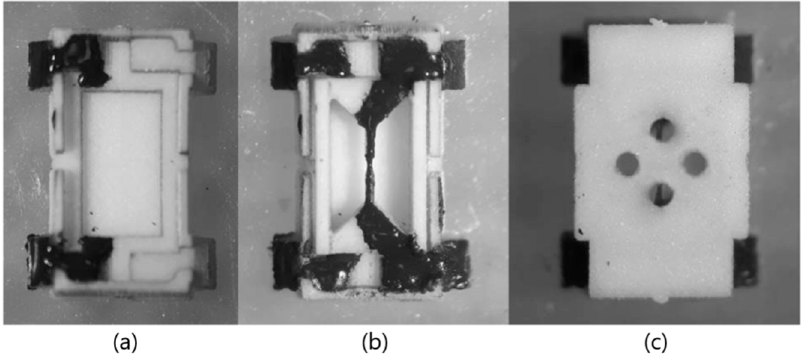
Figure 2. ( a ) Deposited Pt paste on bottom part of SOT-23 package; ( b ) Deposited Pt paste on MEMS part inside SOT-23 package; ( с ) The assembled SOT-23 package before